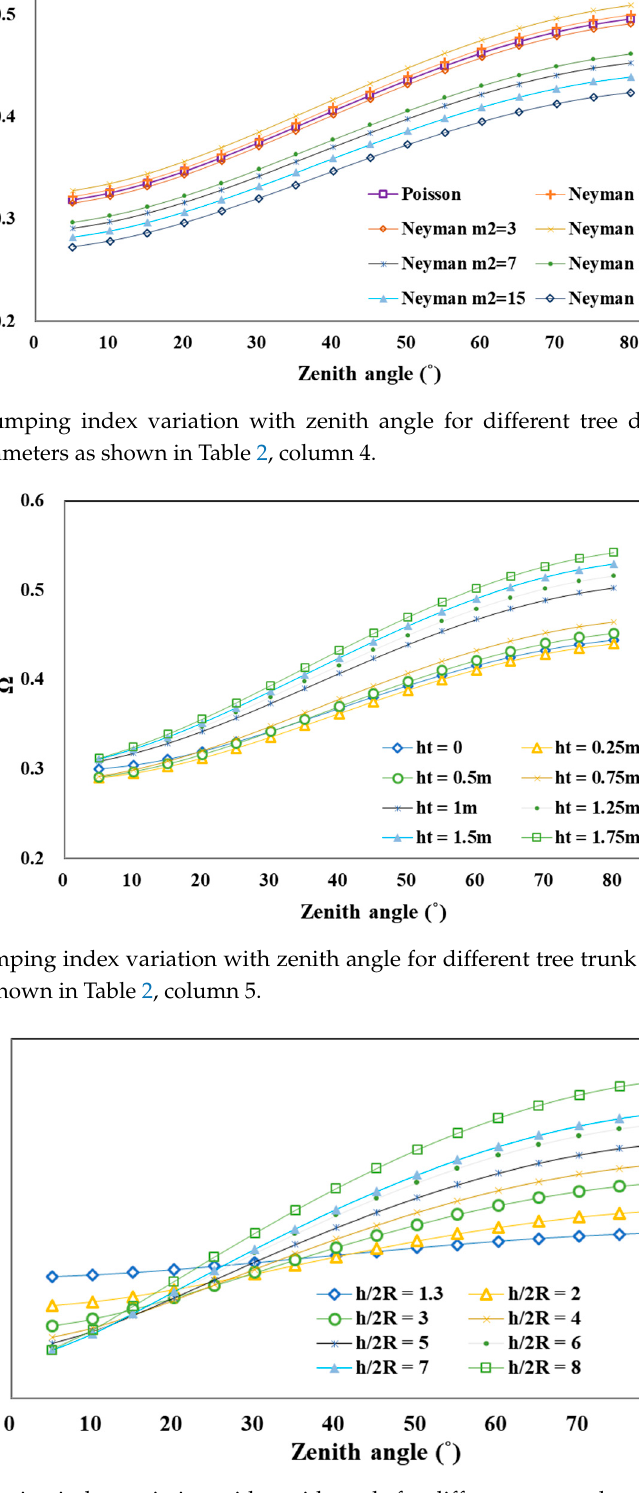
Figure 18. Clumping index variation with zenith angle for different crown shape factors. Simulation parameters, as shown in Table 2, column 6.